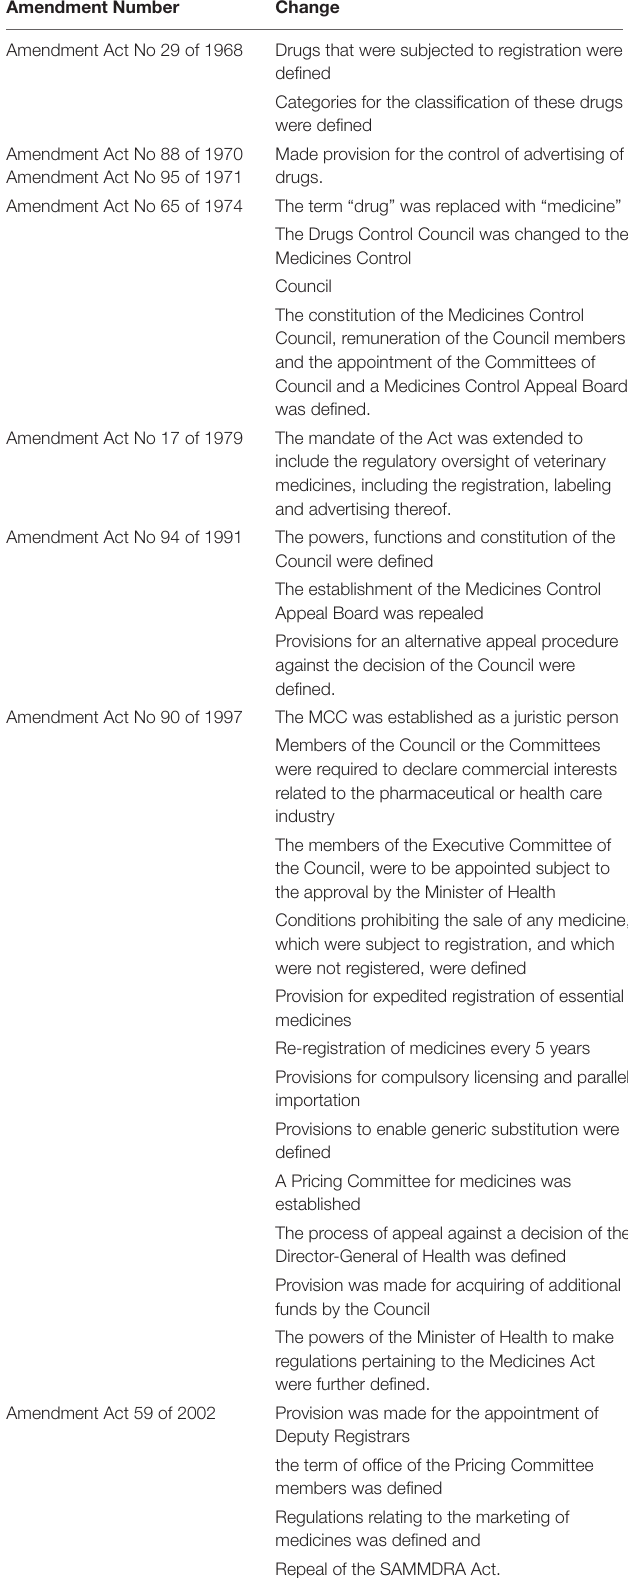
TABLE 1 | Amendments to Drug Control Act